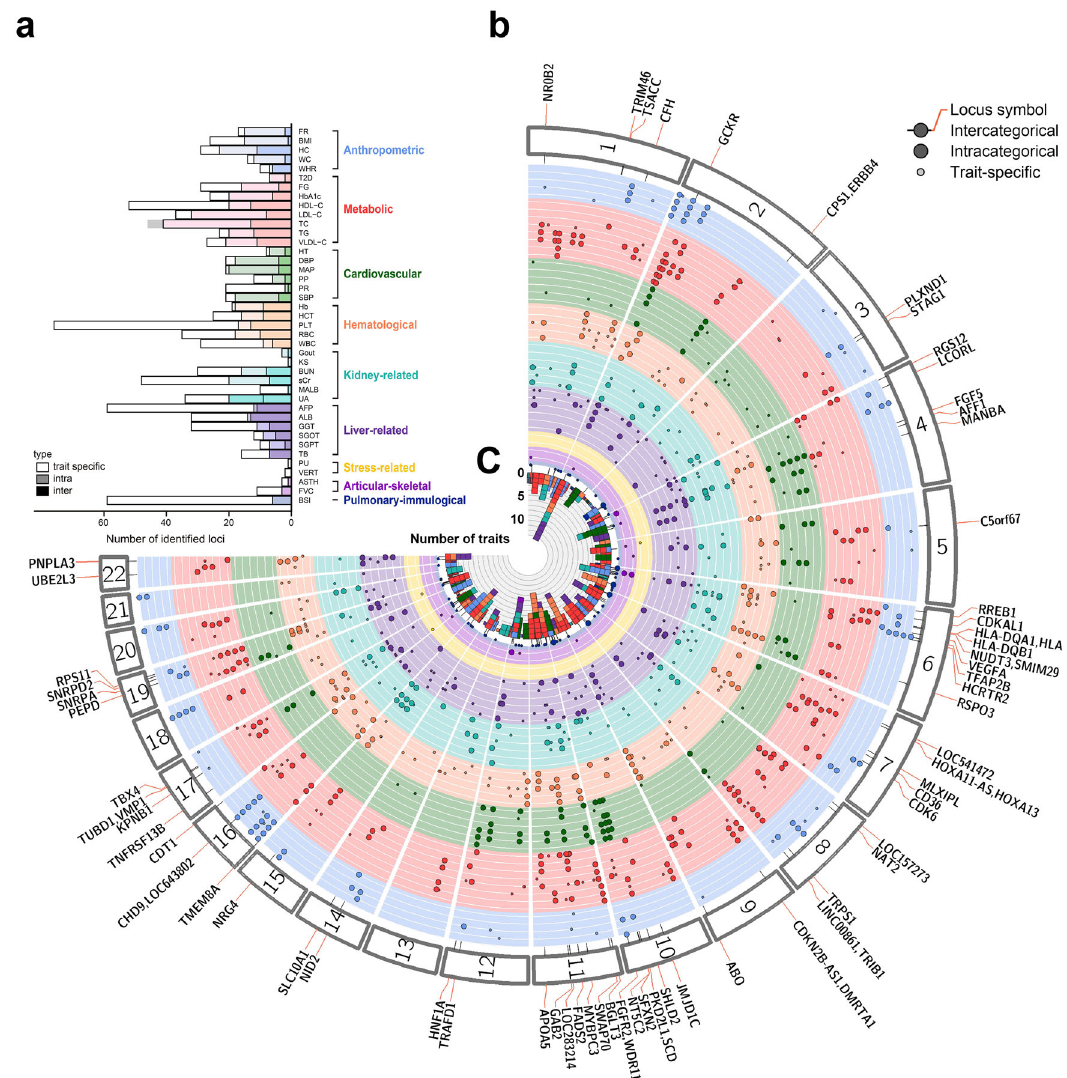
Fig. 1 Overview of loci identi fi ed in this PheWAS and their pleiotropy. a Number of identi fi ed loci for each trait group by trait categories. Color saturation indicates whether the locus has pleiotropic effects. White: trait-speci fi c locus; medium saturation: shared locus within a single trait category; full saturation: shared locus between trait categories. b Fuji plot of the 41 traits having association signals. Each association lead SNP is presented as a dot and arranged by its physical position along the angle starting from the 12 o ’ clock position. Each line corresponds to a trait indicated in ( a ) and each lane is colored by the color of trait category. The larger dots indicate pleiotropic association loci. c The number of associated traits for each inter-categorical pleiotropic